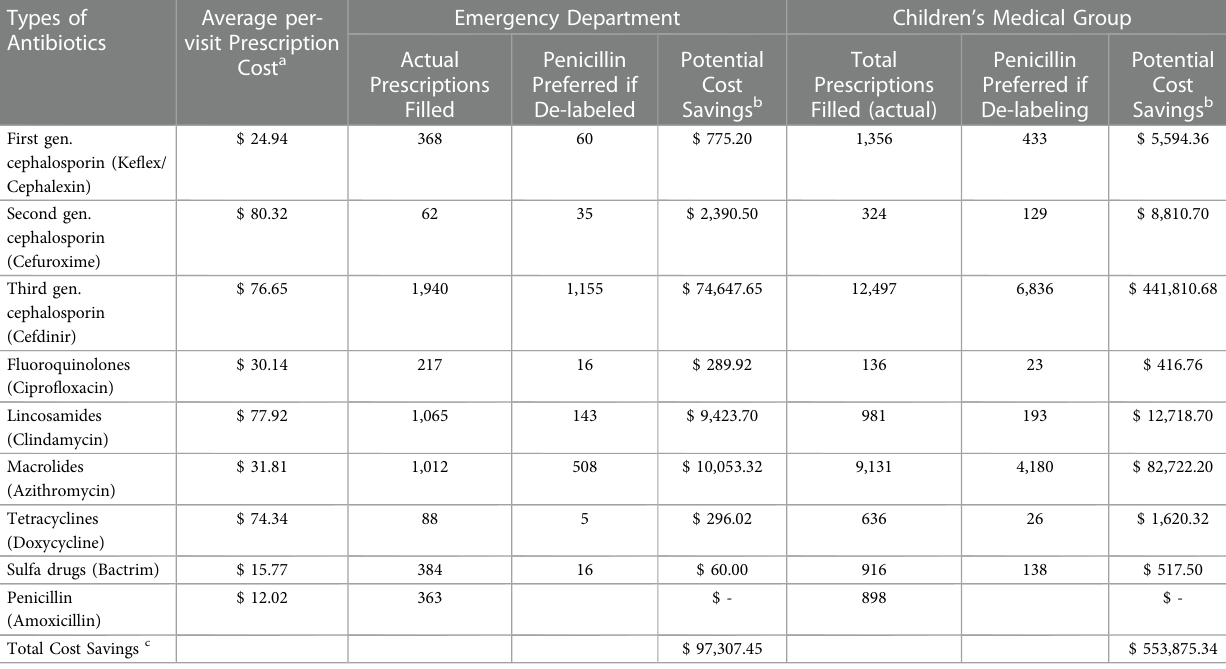
TABLE 1 Potential drug cost savings by types of